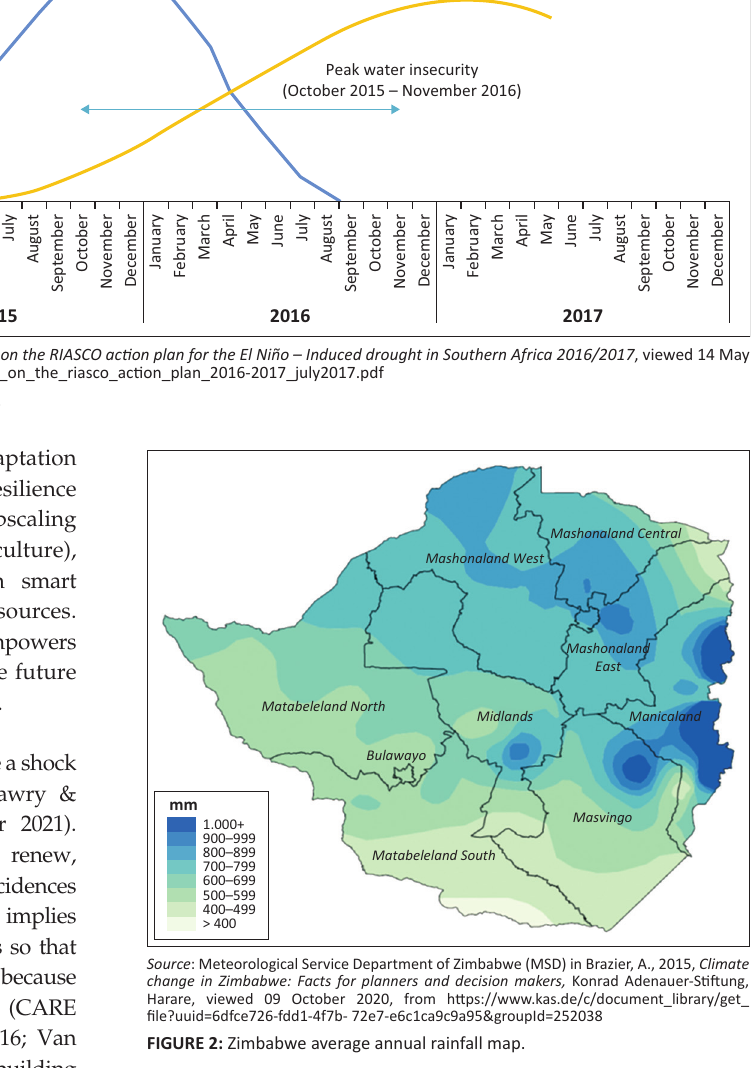
FIGURE 2 : Zimbabwe average annual rainfall